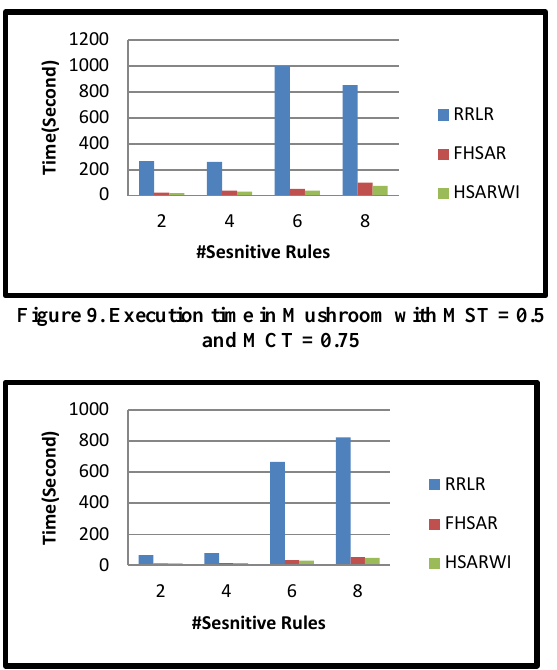
Figure 10. Execution time in Mushroom with MST = 0.4 and MCT =